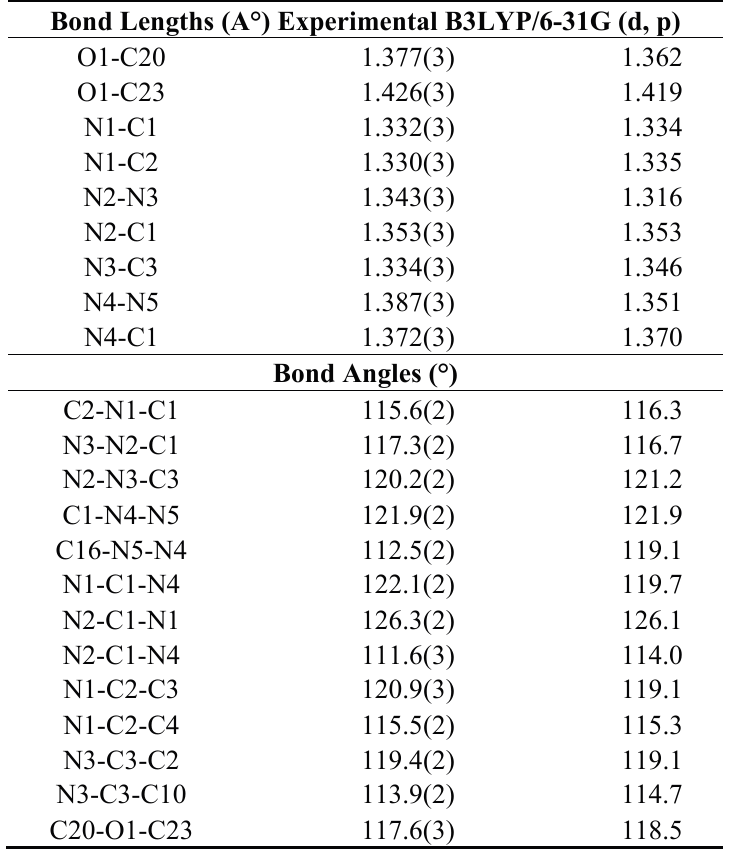
Table 4. Selected molecular structure parameters of compound 2 .